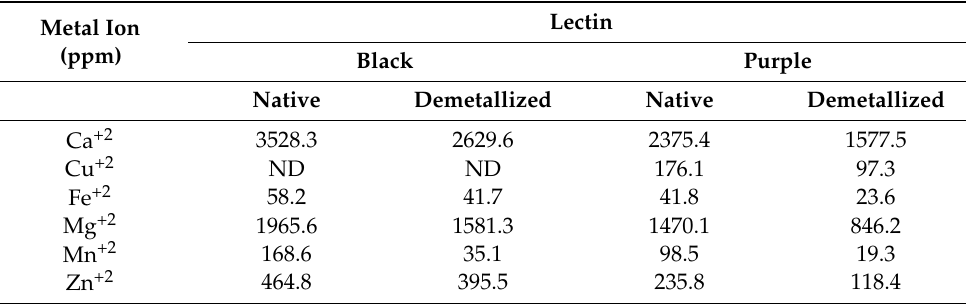
Table 2. Metal ions content in the lectins of two varieties of Phaseolus coccineus in